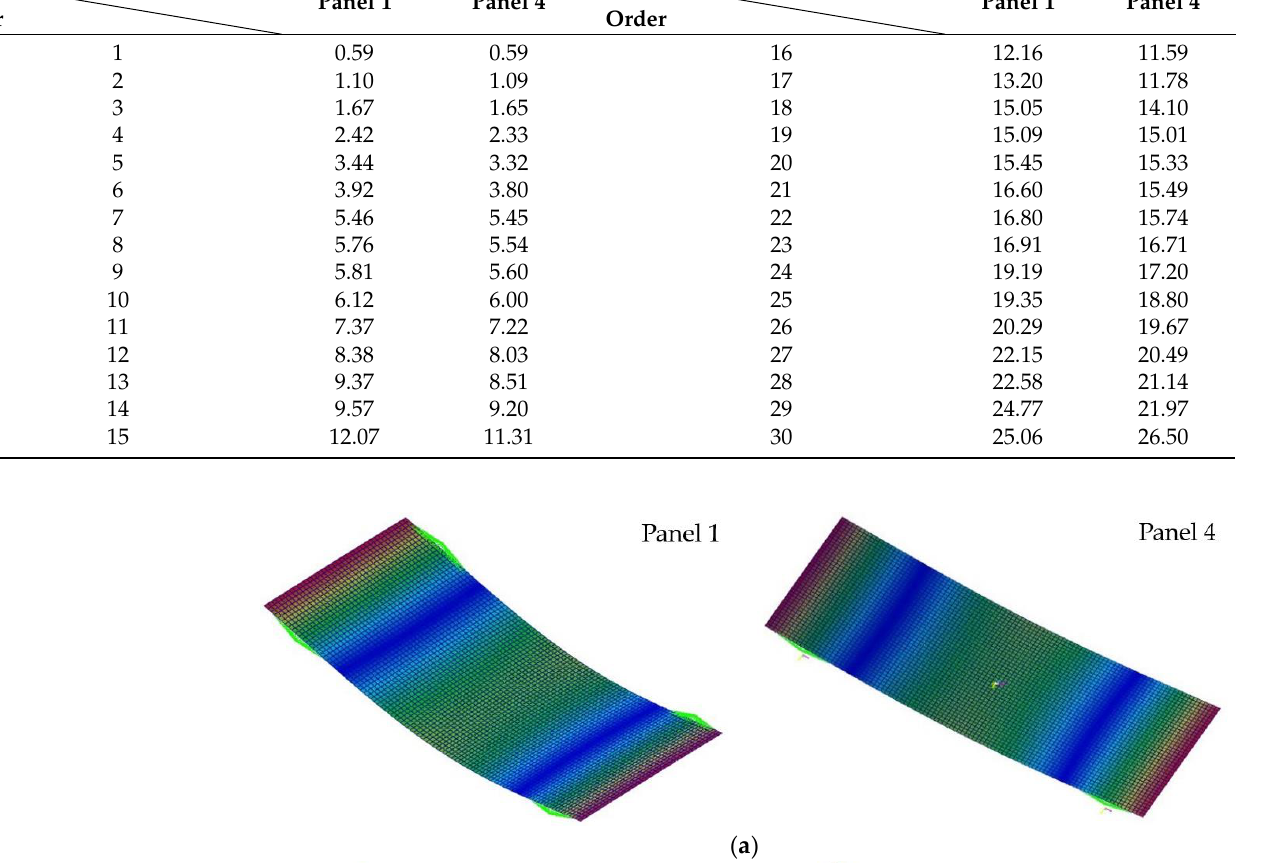
( c ) ( d ) Figure 7. Modes of Panel 1 and Panel 4: ( a ) 1st mode; ( b ) 10th mode; ( c ) 20th mode; ( d ) 30th mode. Because the number and distribution of constraints in Panel 1 were different to those in Panel 4, the vibration shapes of Panel 1 were also slightly different to those of Panel 4. For example, the frequency of the 30th mode of Panel 1 was 25.06 Hz, while it was 26.50 Hz in Panel 4. The modo shapes were also different as shown in Figure 7d.